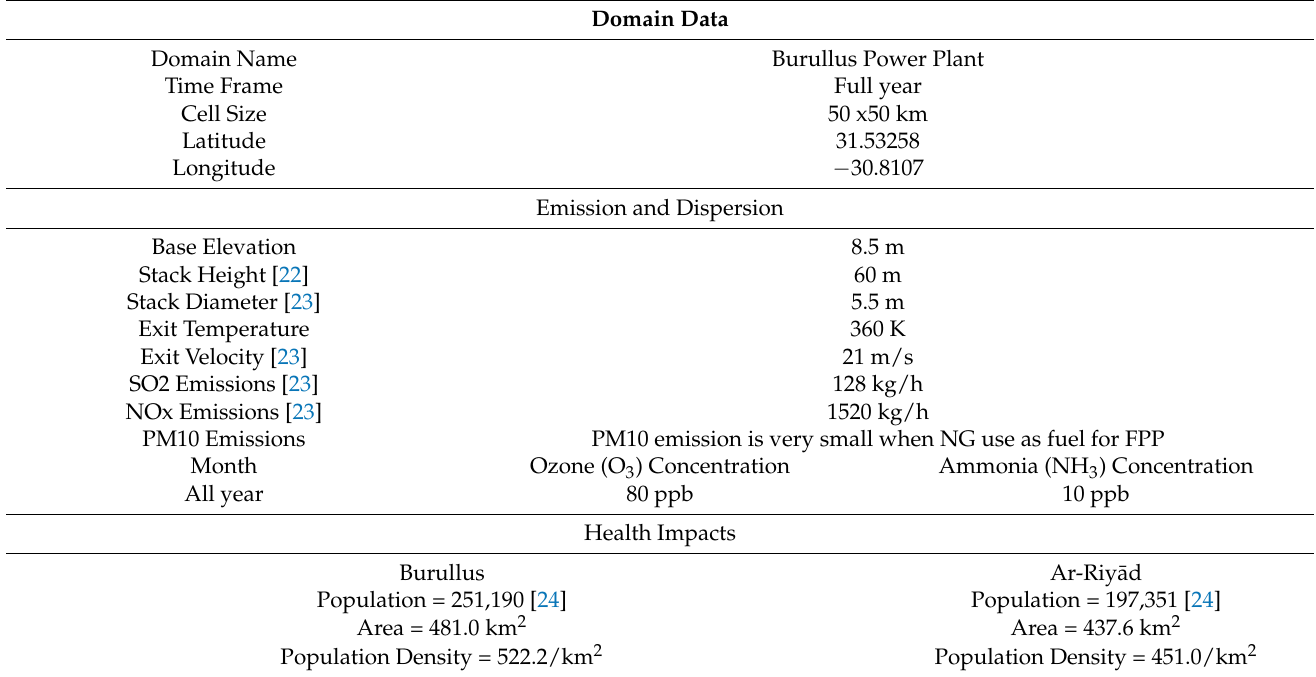
Table 3. Input data of the fossil fuel of Burullus CCPP.